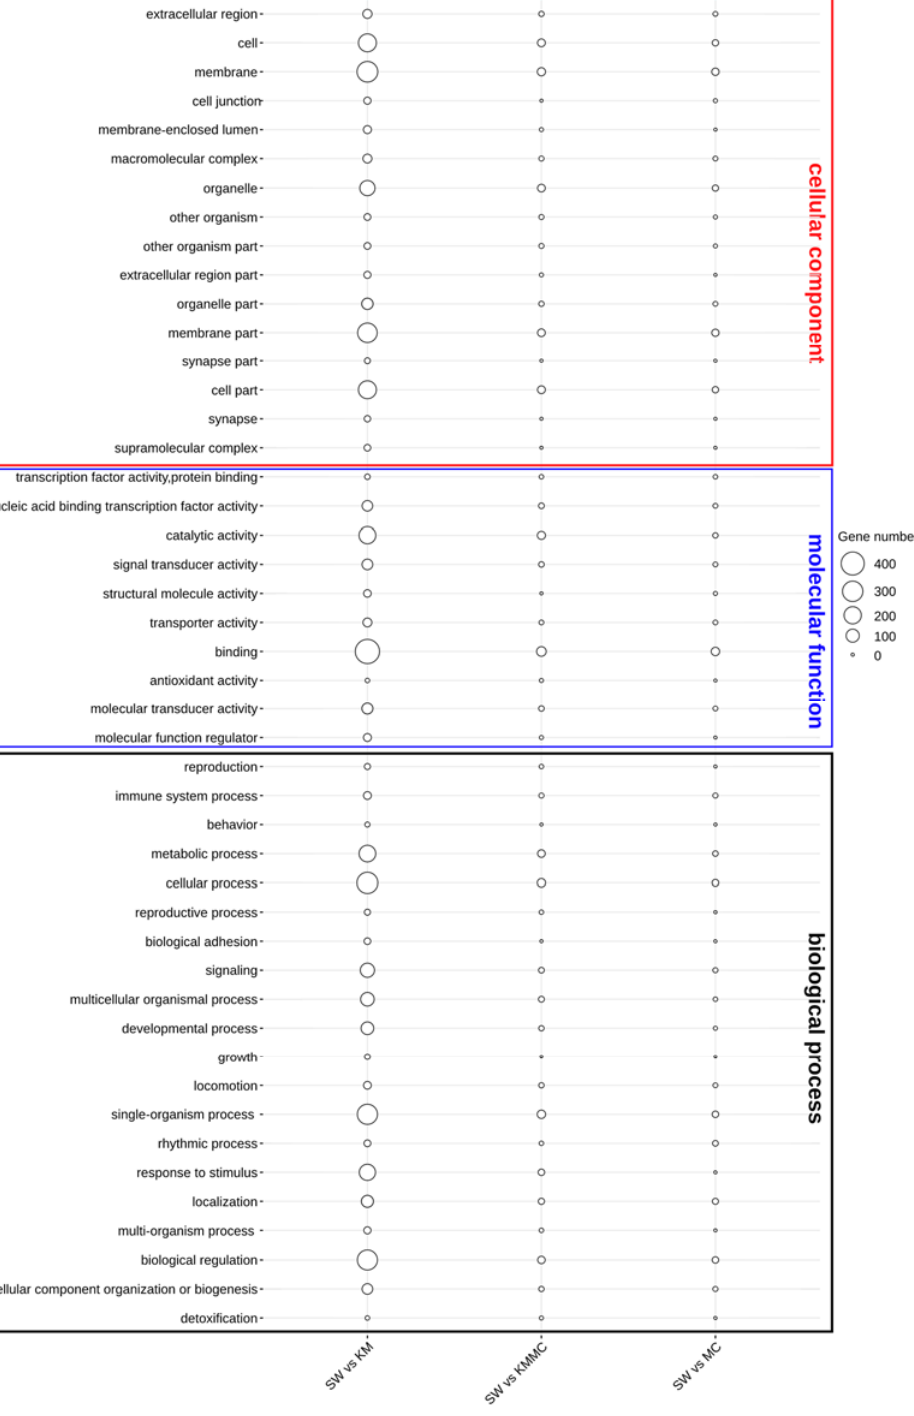
Figure 6. Catalogues of DEGs in biological process, cellular component, and molecular function items.